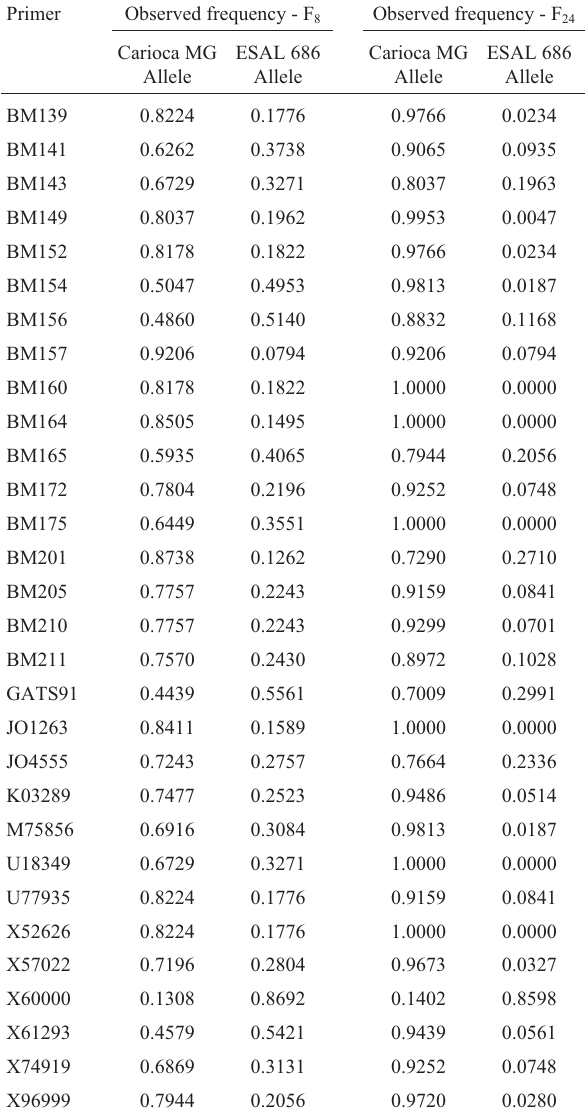
Table 2 - Estimates of the allele frequencies observed in F 8 and F 24 generations of a P. vulgaris cultivar Carioca MG and ESAL 686 cross. The table shows the results for 30 microsatellite